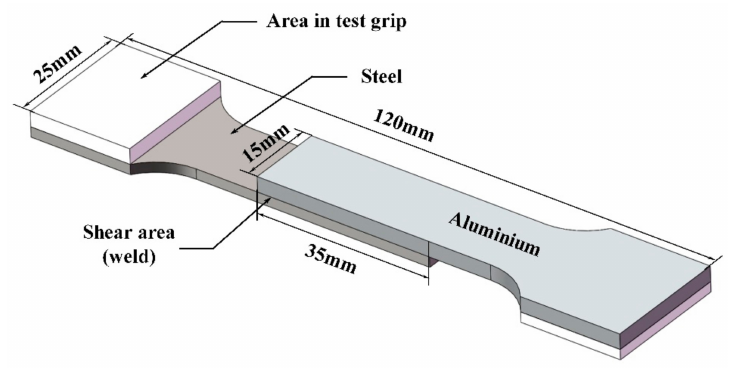
Figure 2. Dimensions of lap shear test